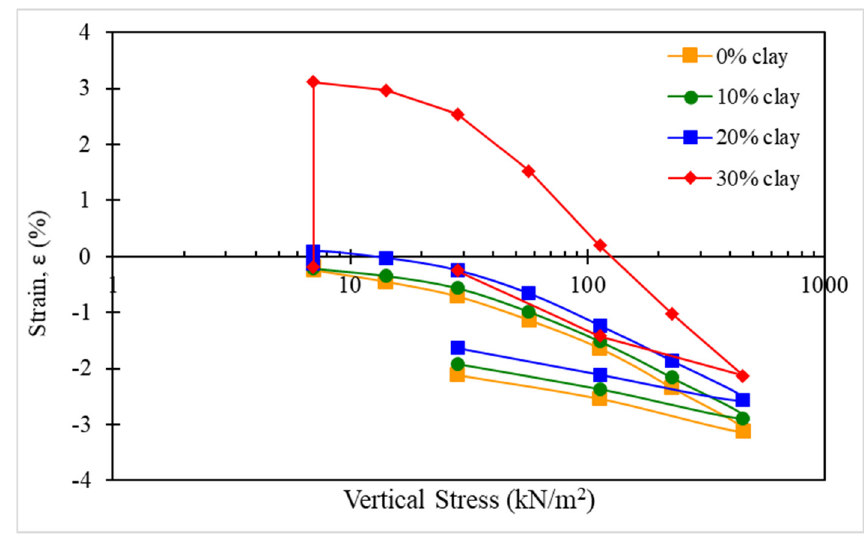
Figure 4. Vertical strain at 24 h vs. stress at variable clay content of the mixtures.